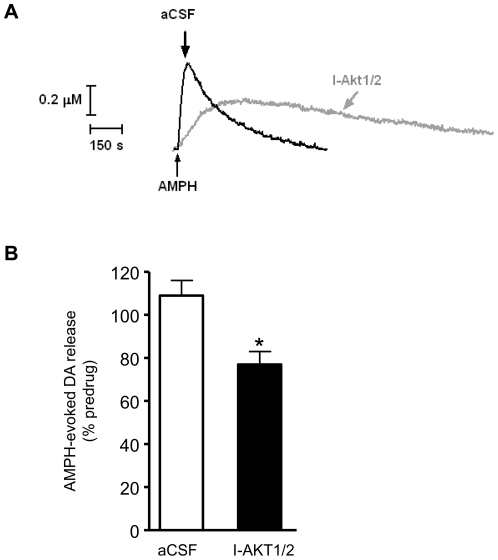
Inhibition of Akt reduces DAT-mediated reverse transport of DA.(A) Representative recordings of striatal extracellular DA release after microinjection of AMPH (400 µM/125 nl) as measured by HSCA. Traces were obtained 45 minutes after microinjection of the inhibitor I-Akt1/2 (1 mM/125 nl, grey trace) or vehicle control (black trace). (B) Quantification of the peak DA release after microinjection of AMPH. (control, n = 9; I-Akt1/2, n = 7; t14 = 3.49, *p<0.01, Student's t-test. ). Data are represented as mean ± S.E.M.